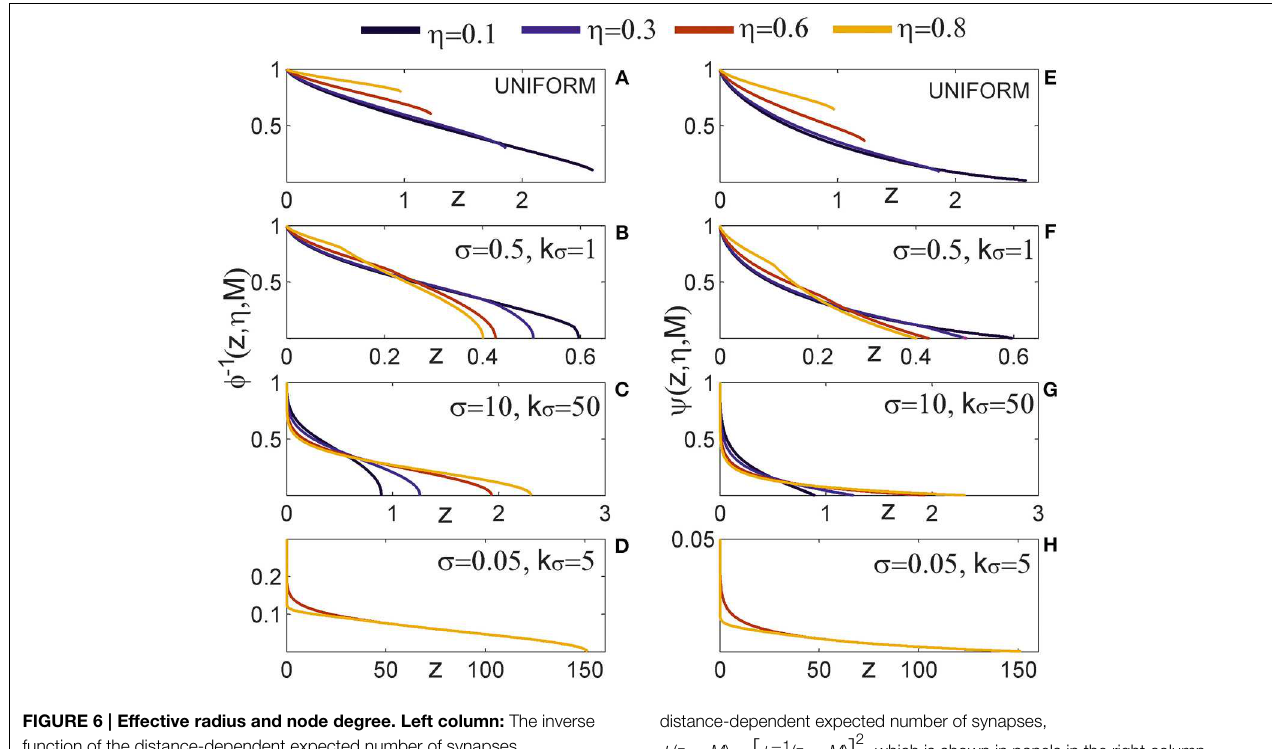
FIGURE 6 | Effective radius and node degree. Left column: The inverse function of the distance-dependent expected number of synapses which maps the non-linear dependency between the effective φ − 1 ( z ,η, M ) radius and the model parameters. The x axis shows the function argument h i R 2 π which takes values from the interval [ 0 ,φ max ] . Right column: z = 2 NaN d D 2 The node degree is a quadratic function of the effective radius in the considered model. It depends on the square of the inverse